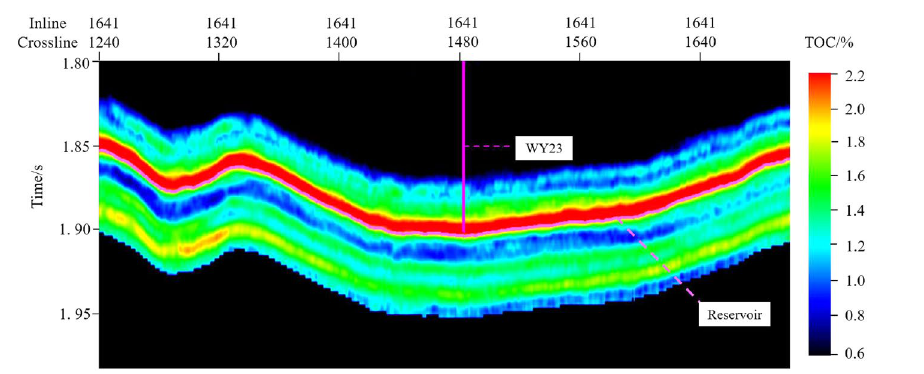
Figure 12. TOC section view of the Longmaxi formation.